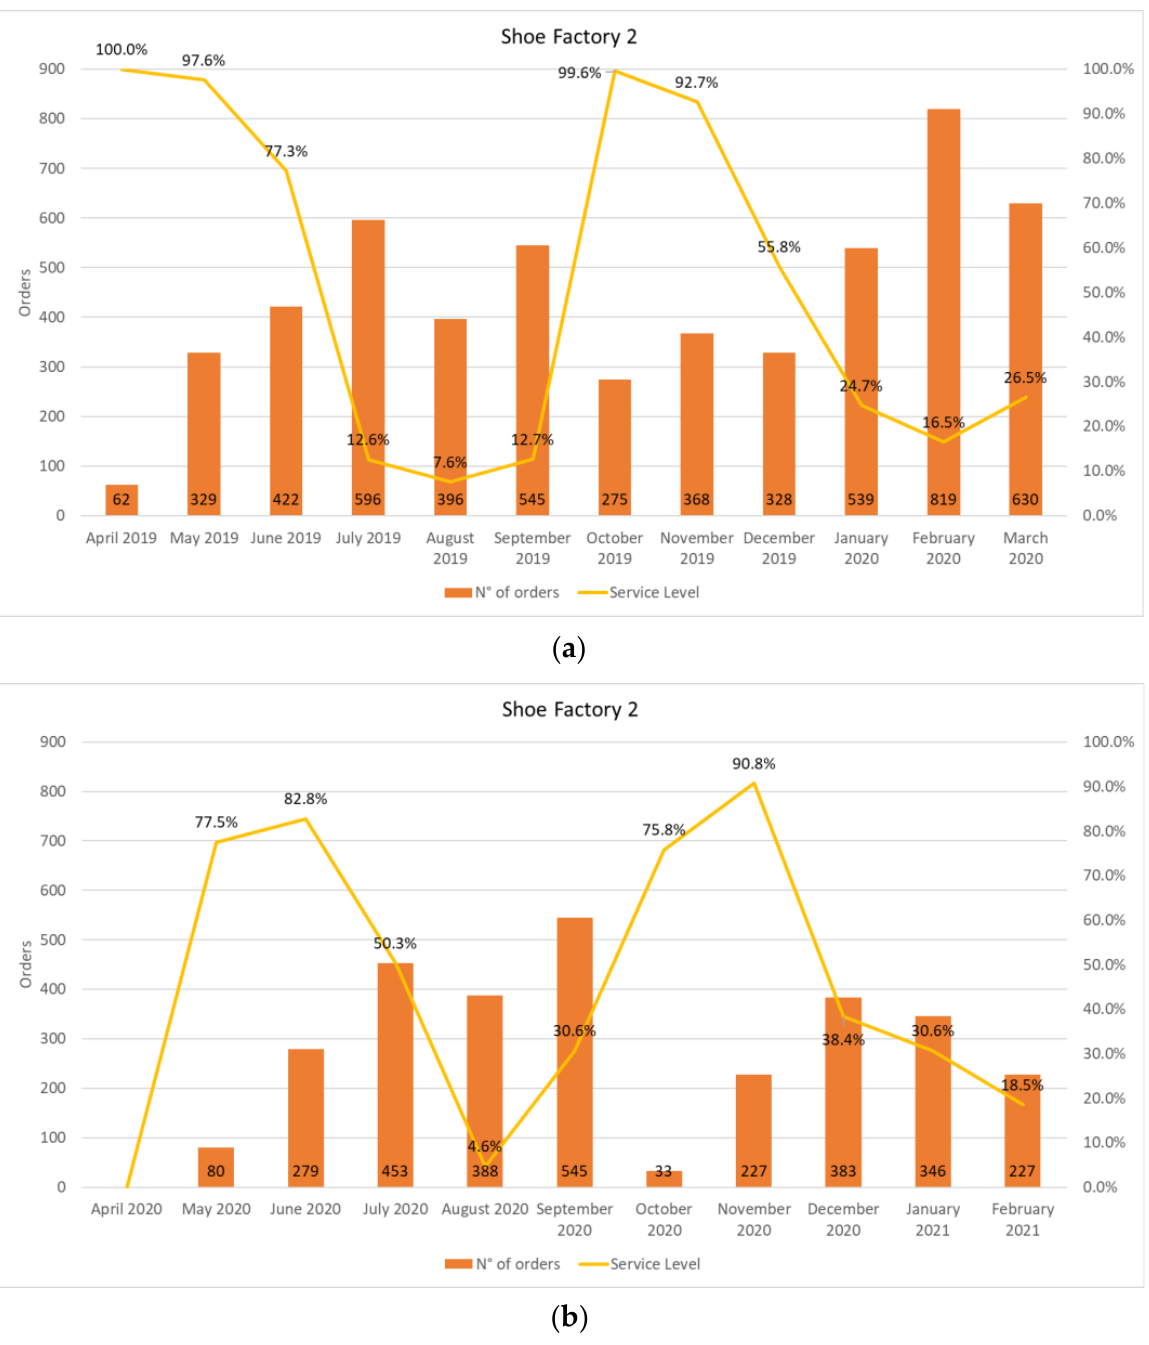
Figure 7. Shoe Factory 2 — monthly Service Level and N° of orders, considering AW19-SS20 seasons ( a ) and AW20-SS21 seasons ( b ).